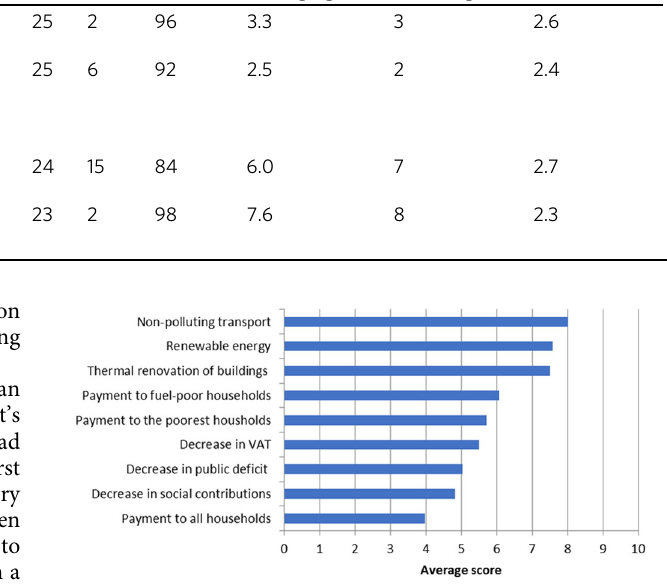
Fig. 2 Preferences regarding carbon tax-revenue recycling. Surveyed in Session 2, between 111 and 118 respondents, depending on the options. The question asked was: “ To what extent [on a 0 – 10 scale] would you accept an increase in the carbon tax if the revenue were used to …”